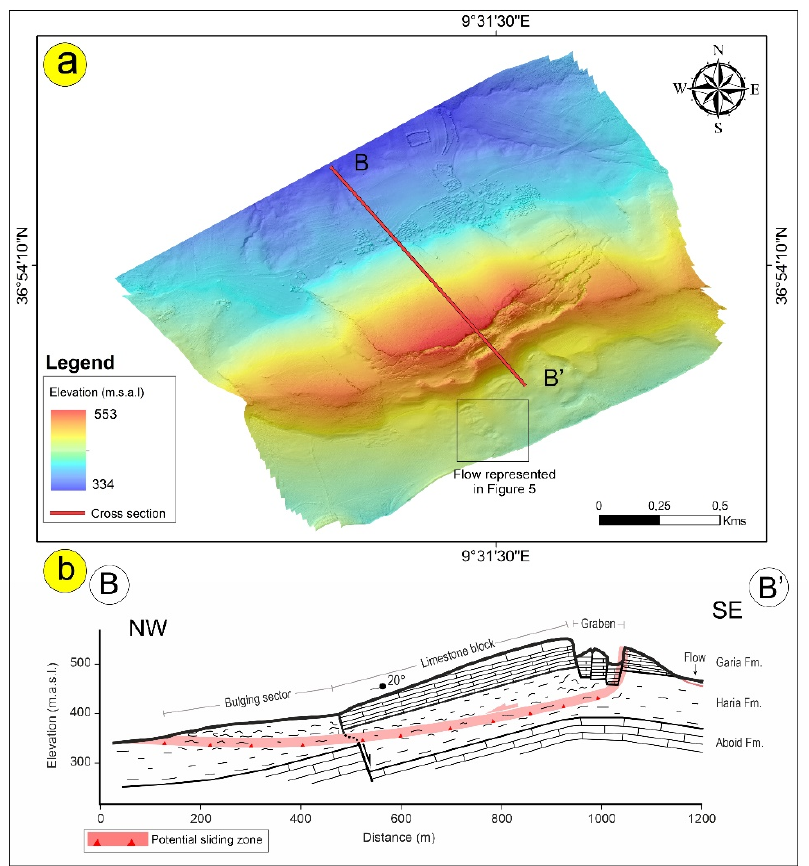
Figure 15. ( a ) High resolution DEM generated using UAV-DP technique and ( b ) BB’ detailed cross- section showing the Chgega Mountain.